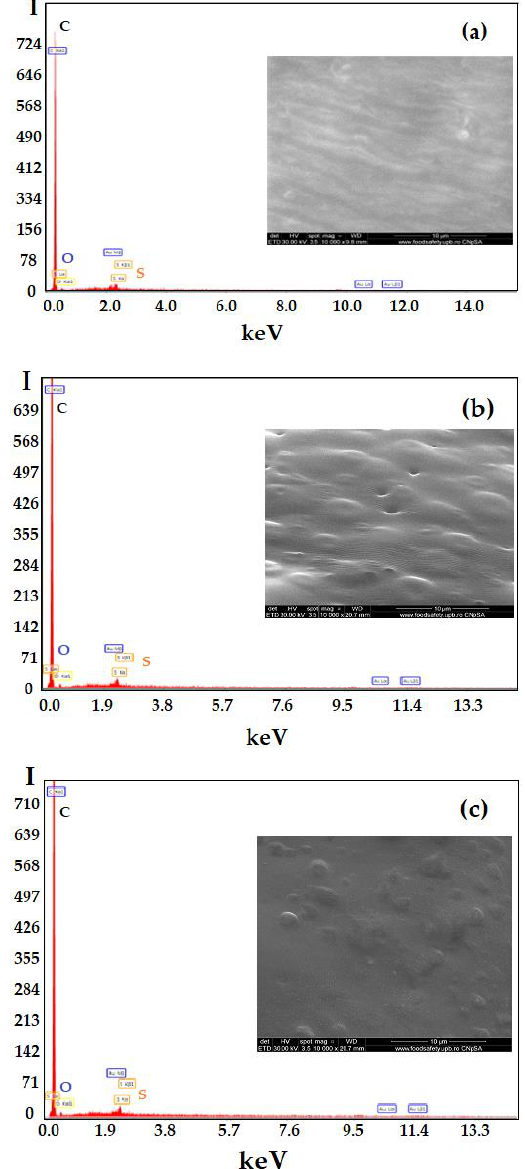
Figure 6. Energy-dispersive spectroscopy analysis (EDAX) diagram for: sulfonated ethylene-propylene-diene terpolymer (sEPDM) (M1) ( a ); chitosan (Chi) – sulfonated ethylene-propylene-diene terpolymer (Chi-sEPDM) (M2) ( b ), melatonin/chitosan (Chi) – sulfonated ethylene-propylene-diene terpolymer (Mel-Chi-sEPDM) (M3) ( c ).